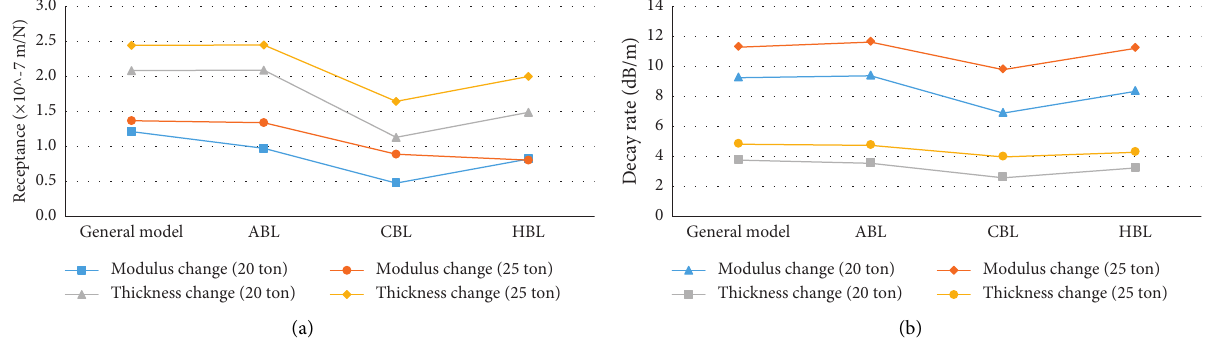
Figure 13: The effect of modulus and thickness on receptance and decay rate in layers under various vehicle load amplitudes: (a) modulus and thickness change of the slab track layers under receptance and (b) modulus and thickness change of the slab track layers under decay